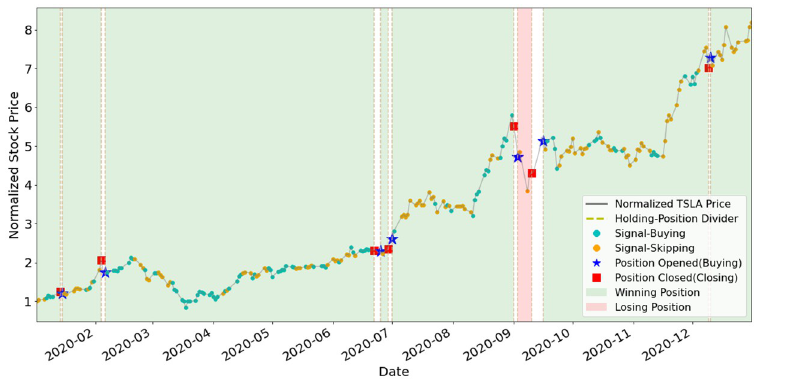
Fig 15. Signals and position-holding of TSLA’s